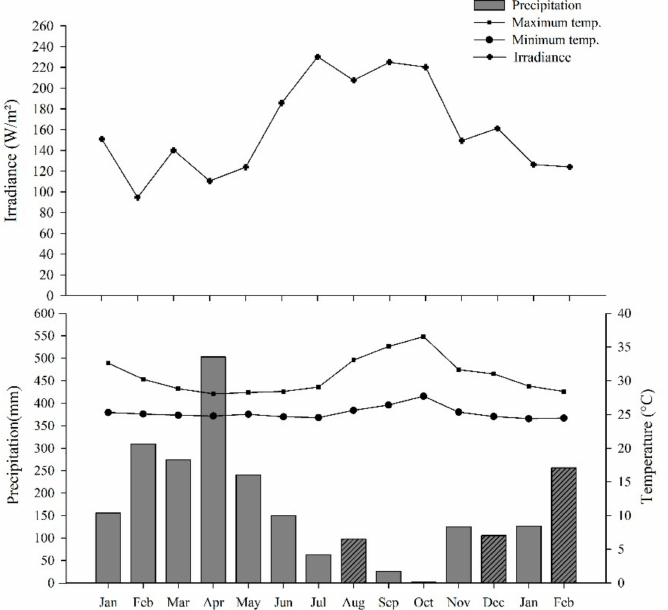
Figure 7. Precipitation (mm), maximum and minimum temperature ( ◦ C), and monthly solar